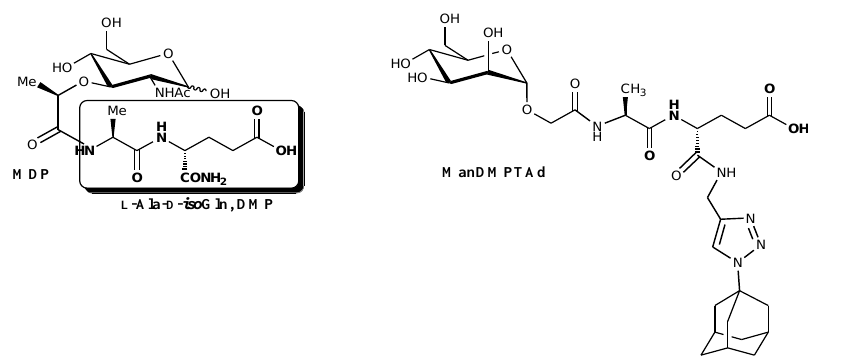
Figure 1. Structure of MDP, DMP and mannosylated adamantyl-triazole DMP derivative.